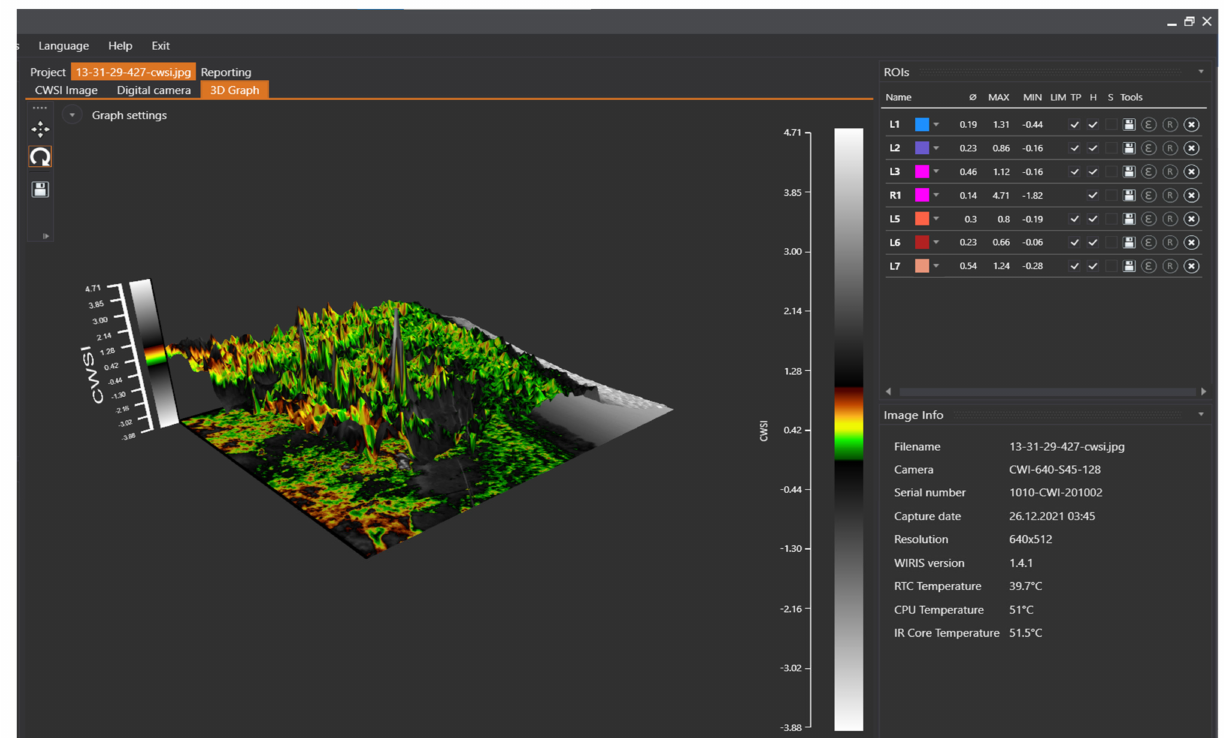
Figure 11. 3D graph of the thermal data obtained by the